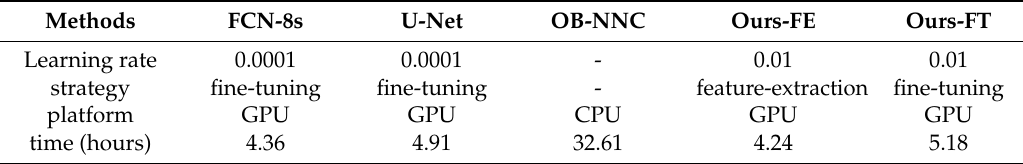
Table 3. Experiments setup and computational complexity between classification schemes. OB-NNC: object-based nearest neighbor classification (NNC) method. Ours-FE: our feature extraction method. Ours-FT: our fine-tuning method. GPU: Tesla P40 graphics processing units. CPU: inter i7 7700k